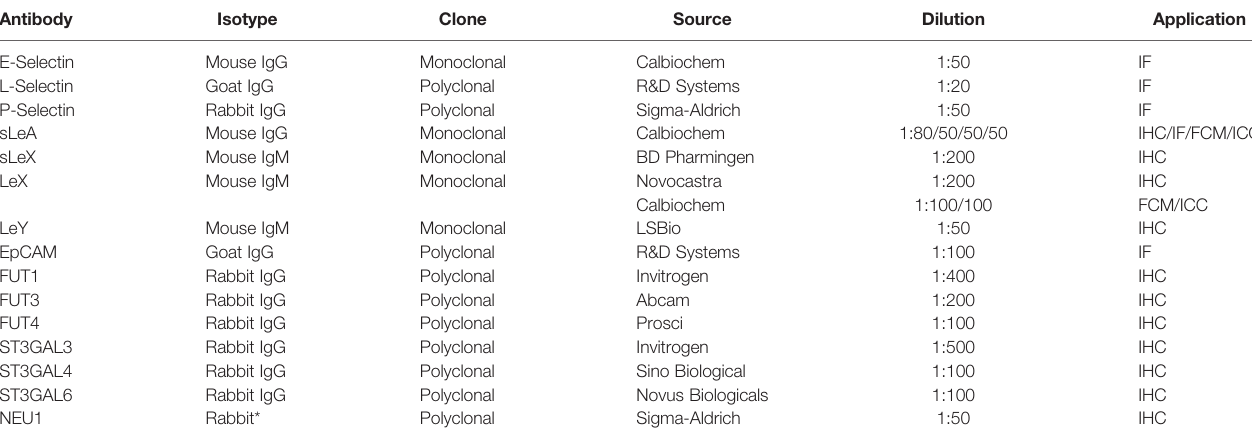
TABLE 2 | Details of primary antibodies used in this